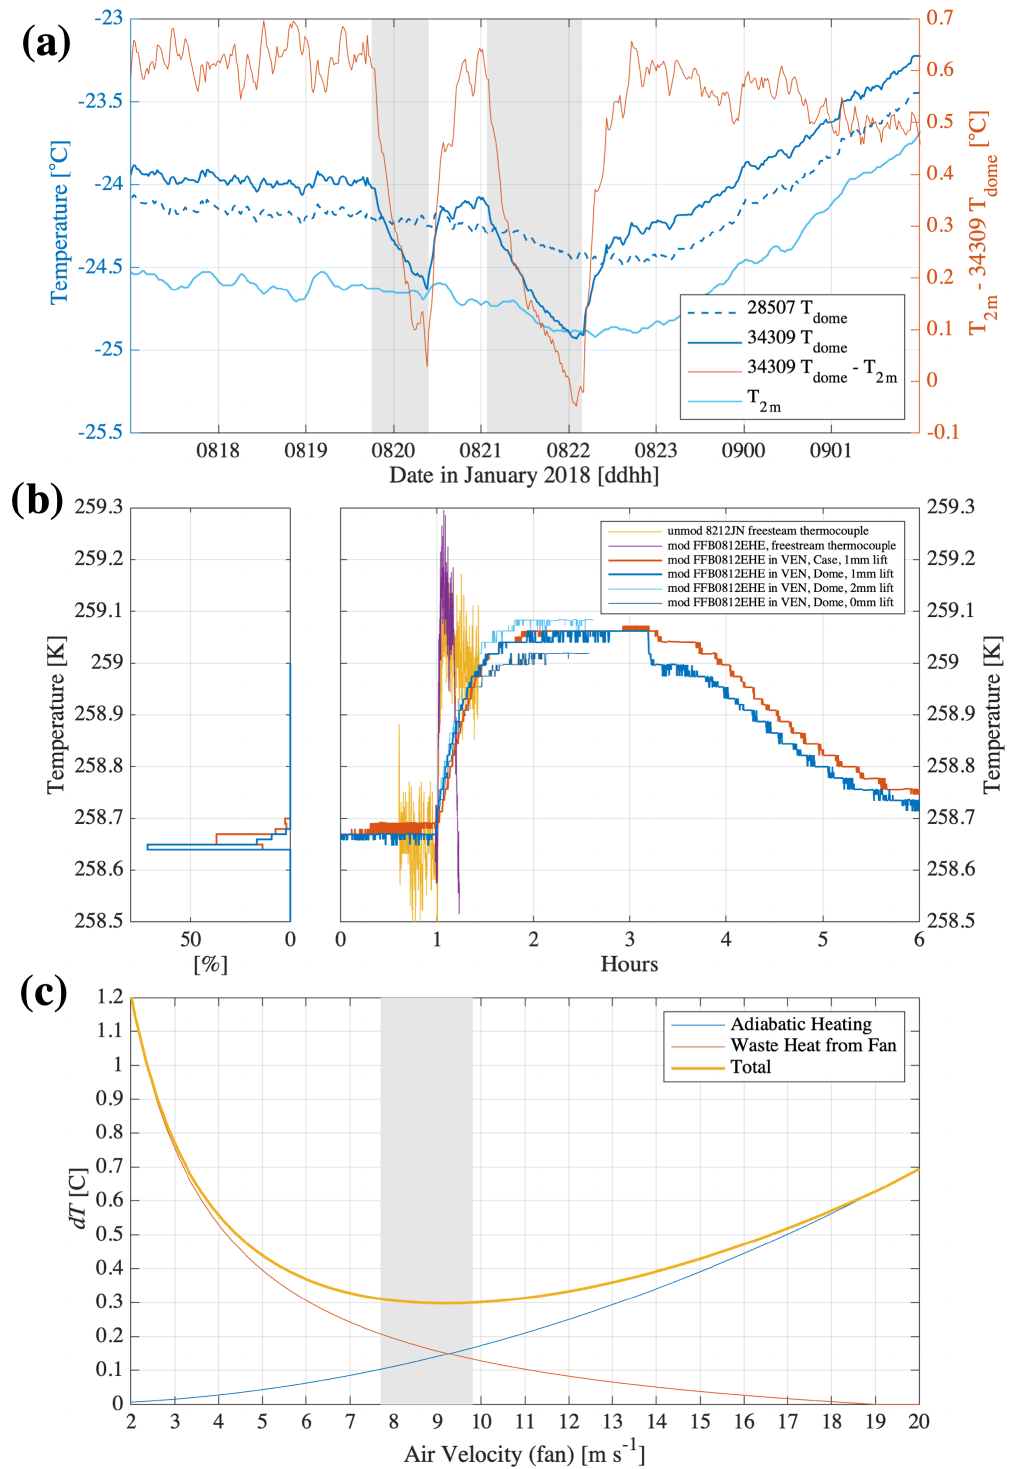
Figure 9. (a) Case study from D-ICE on 8–9 January 2018 showing the dome temperatures of PIR 28507 (dashed blue), PIR 34309 (solid blue), the 2m air temperature (light blue), and the difference in the two dome temperatures (red, right-side axis). The grey shading highlights periods when the ventilator in 34309 was turned off. (b) Laboratory tests carried out in a cold chamber in Boulder, Colorado, using various configurations of the Eppley VEN ventilator housing an FFB0812EHE fan (red and blues) as well as tests with an FFB0812EHE (purple) and 8212JN (yellow) fan without the VEN. The tests are described in Sect. 4.2. (c) Theoretical calculations of heating from FFB0812EHE fan waste heat (Eq. 2) (red), adiabatic compression (Eq. 3) (blue), and the sum of both (yellow). The grey shading in (c) is the range of observed air velocities near the top of the PIR dome in an Eppley